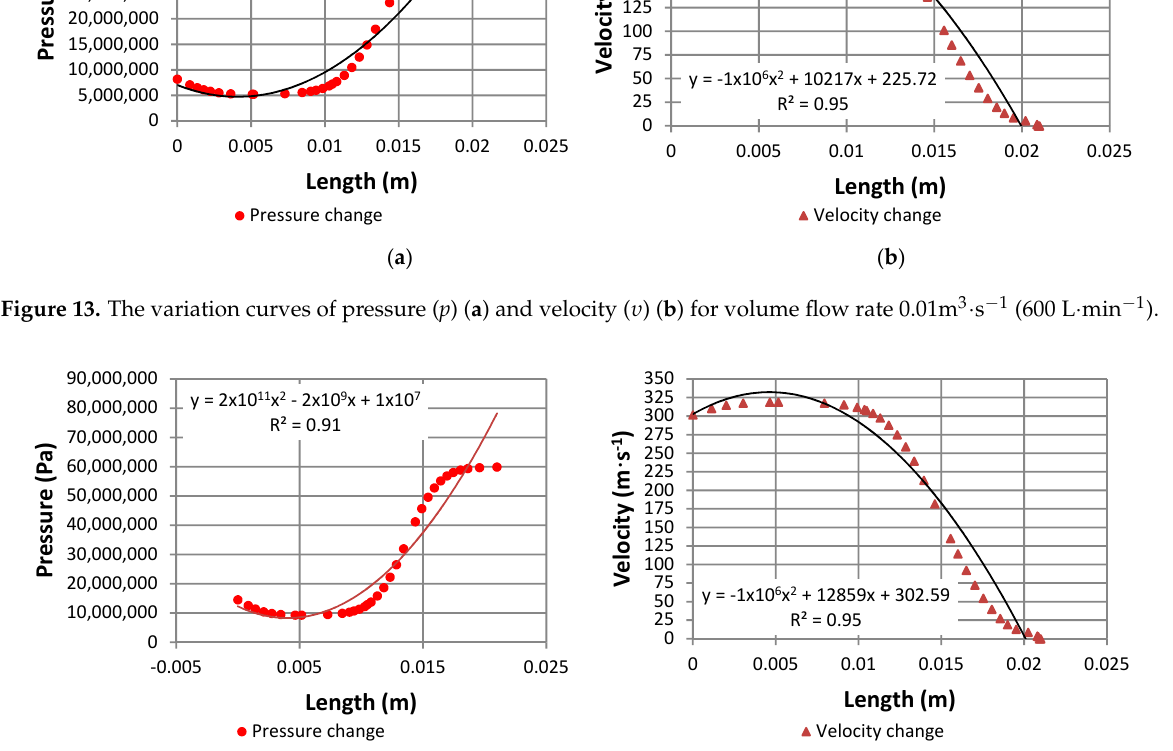
Figure 13. The variation curves of pressure ( p ) ( a ) and velocity ( υ ) ( b ) for volume flow rate 0.01m 3 ·s -1 (600 L·min -1 ).